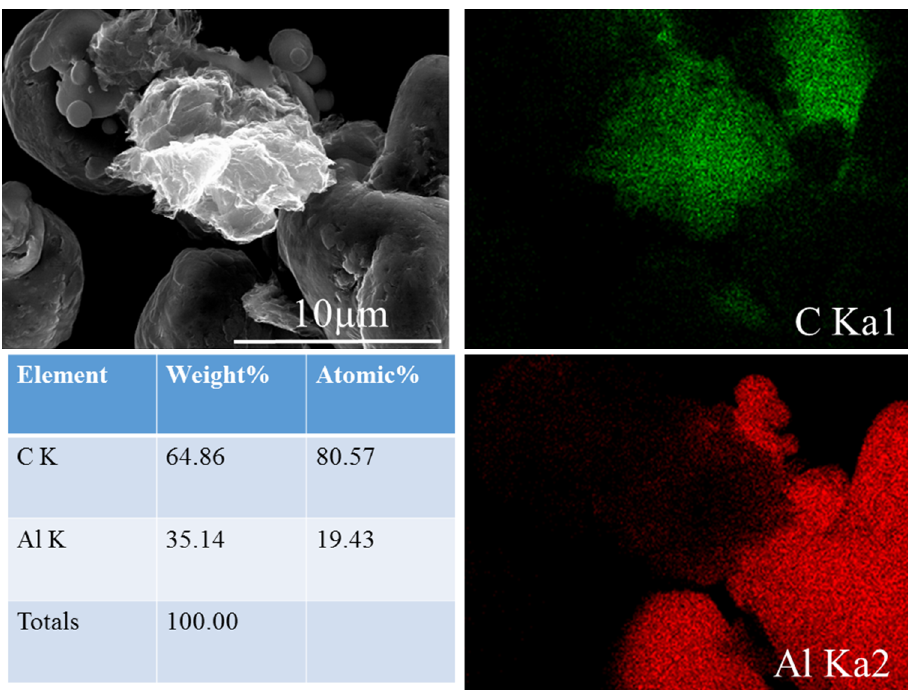
Figure 7. Mapping using EDS.